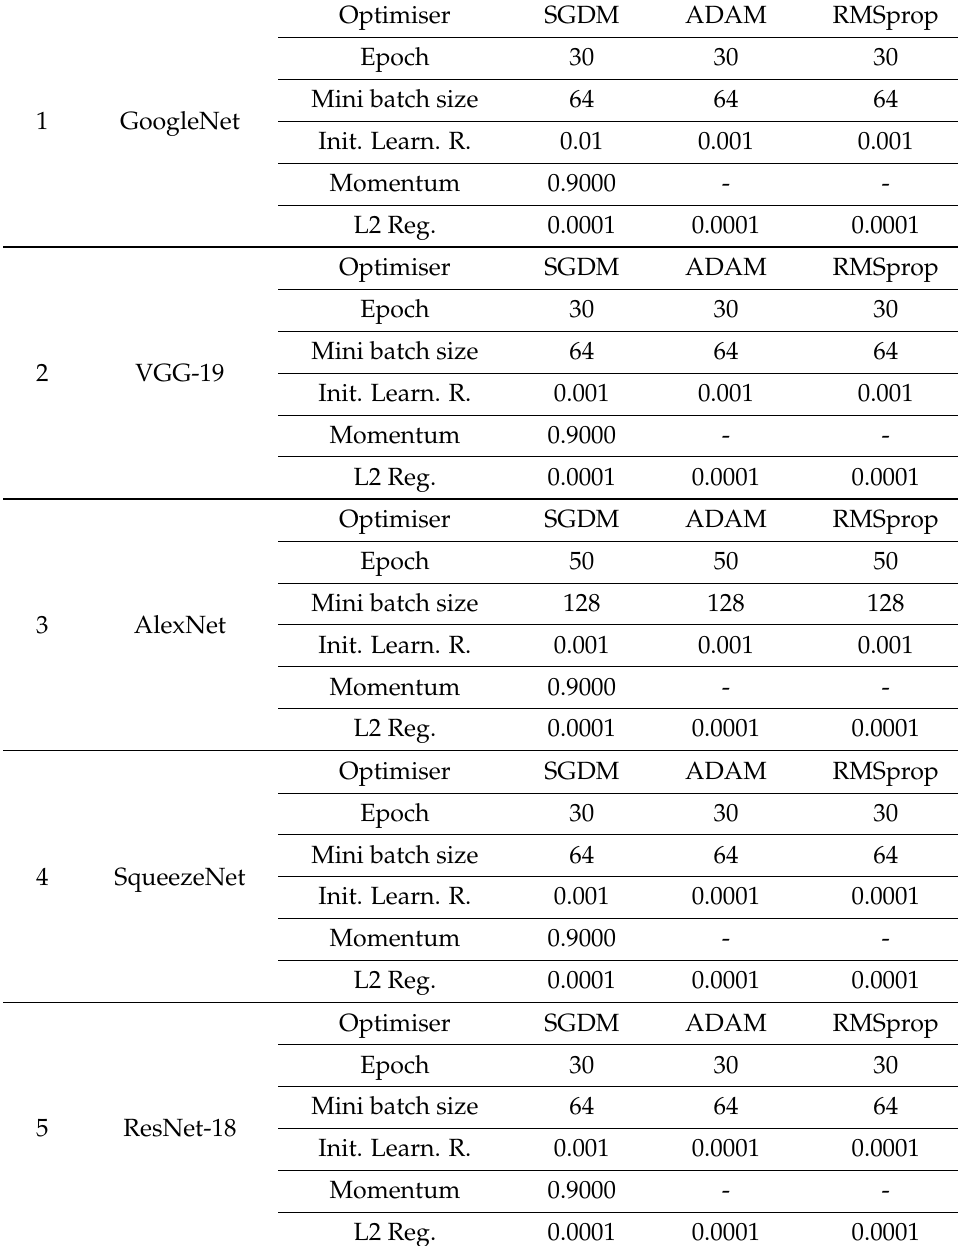
Table 4. Summary of convolutional neural networks (CNNs) hyper-parameters for this